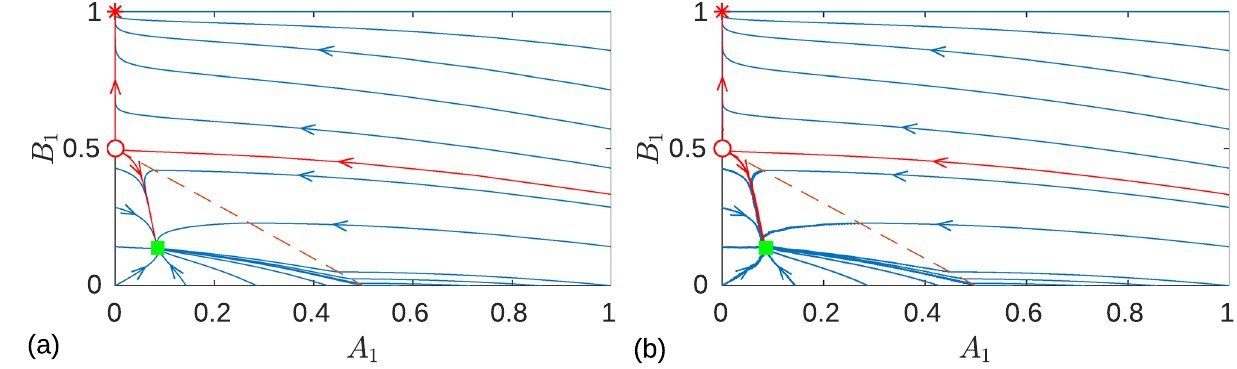
Figure 1. Comparisson of ( a ) the phase portrait in the plane of slow variables ( A 1 , B 1 ) obtained from the reduced system of Eqs. (11) and (15) with ( b ) the projection of the solution of the original system of Eqs. (cid:31) divides the areas of synchronized B 1 (3) and (7) to the same plane ( A 1 , B 1 ). The red dashed line A 1 + = B 1 > � ) and unsynchronized ( A 1 B 1 < � ) motion of the oscillators. The red star and green square ( A 1 + + indicate the stable fixed points of the synchronized and desynchronized system, respectively. The red circle marks a saddle point, and red trajectories represent its separatrices. The stable separatrix separates the basins of attraction of the two stable fixed points. The red circle and green square represent true fixed points in panel ( a ) only, while in panel ( b ) they can only be roughly interpreted as fixed points (see main text for details). The 0.2 . Other parameters are: results are presented for the sigmoid boundary function (5) whith the parameter µ = 1 , ω 1 1 , τ 0.15 , τ 0.3 , and ε 0.01 0.5 , α ω 0 = = = = + = − = ( K , ϕ 1 ) (16) G = ±